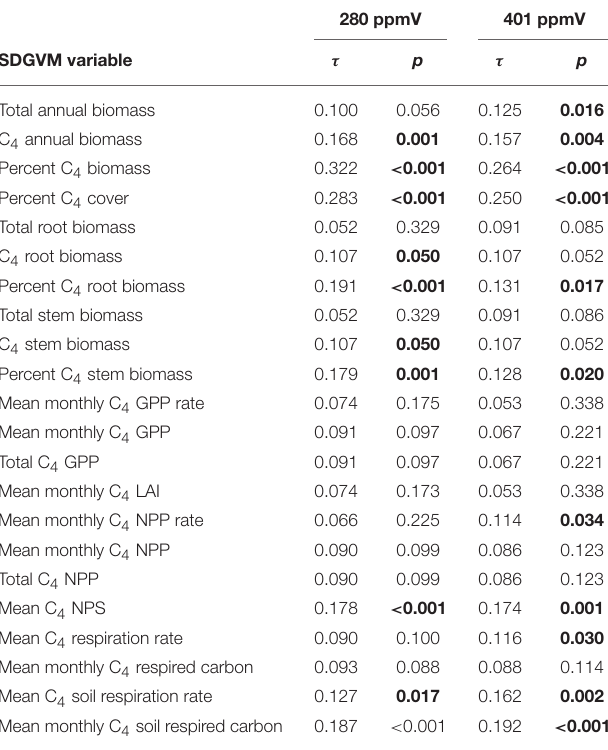
TABLE 1 | Kendall’s rank correlation coefficients ( τ ) and p -values for comparisons of estimates of mean percent C 4 biomass from δ 13 C-values of Miocene paleosol carbonate with results of two cases of the